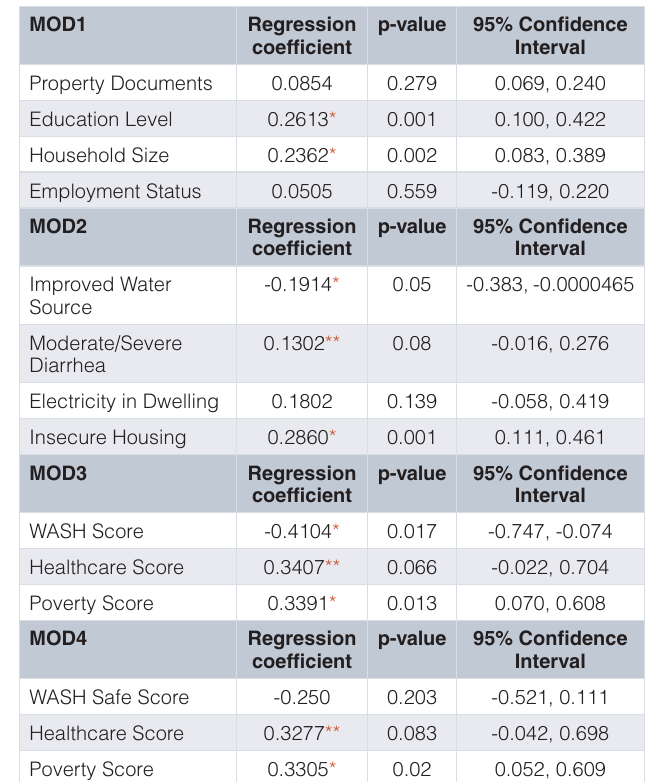
Table 4. Multivariate analysis modelling. Romania, 2016. All models use non-Roma as reference. * indicates significance at 95% CI level. ** indicates significance at 90% CI level.